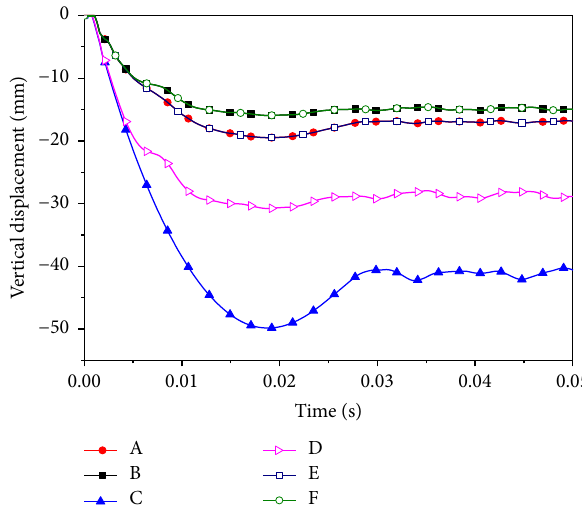
Figure 25: Vertical displacement–time history curve.